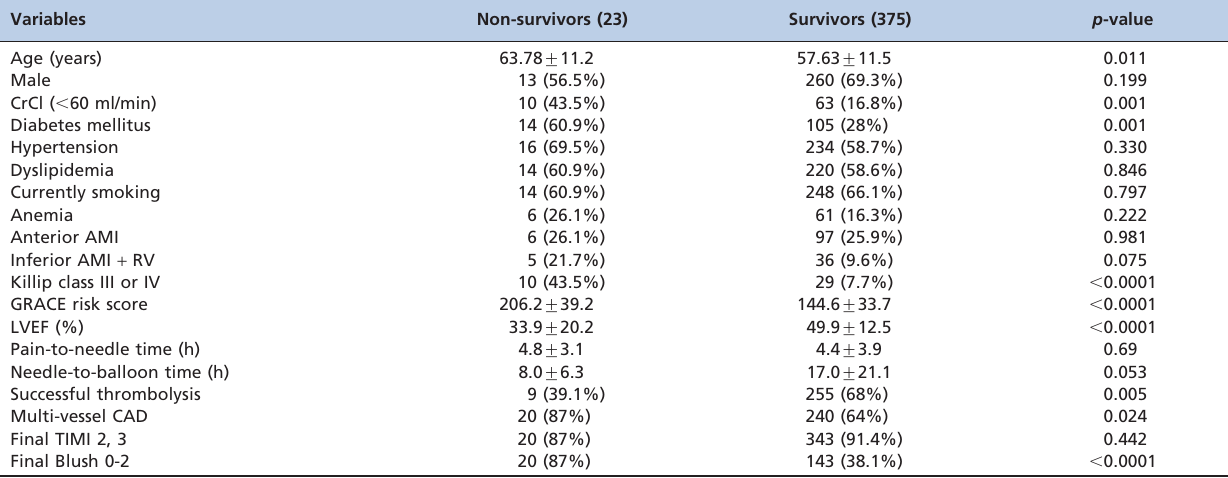
Table 1 - Baseline, clinical, and procedural characteristics of non-survivors vs. survivors. Variables